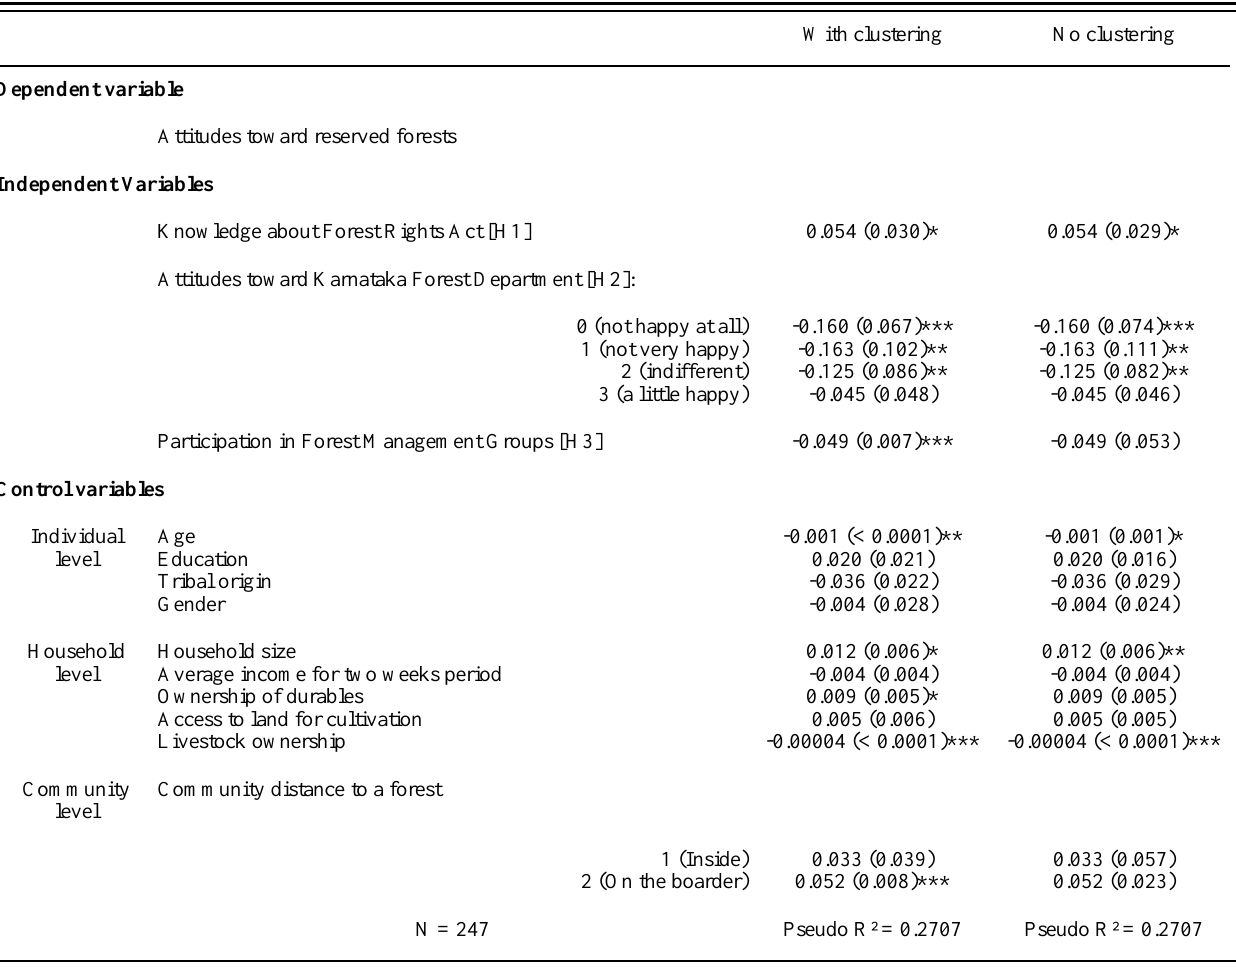
Table 2. Probit models with and without clustering by tenure and management regimes (coffee plantations, reserved forest, national park) explain factors that are associated with the attitudes toward reserved forests (N = 247). Coefficients represent change in marginal probability and + or - sign shows direction of association. Asterisks denote level of significance: * at 10%; ** at 5%; *** at 1%. Robust standard errors are in parentheses. Parameter pseudo R2 is a measure of goodness of